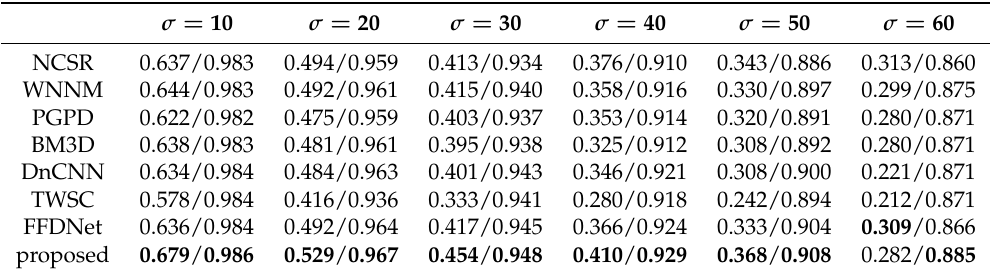
Table 4. Average VIF/IW-SSIM values obtained for the competing methods evaluated on commonly used test images with noise level σ = 10, 20, 30, 40, 50 and